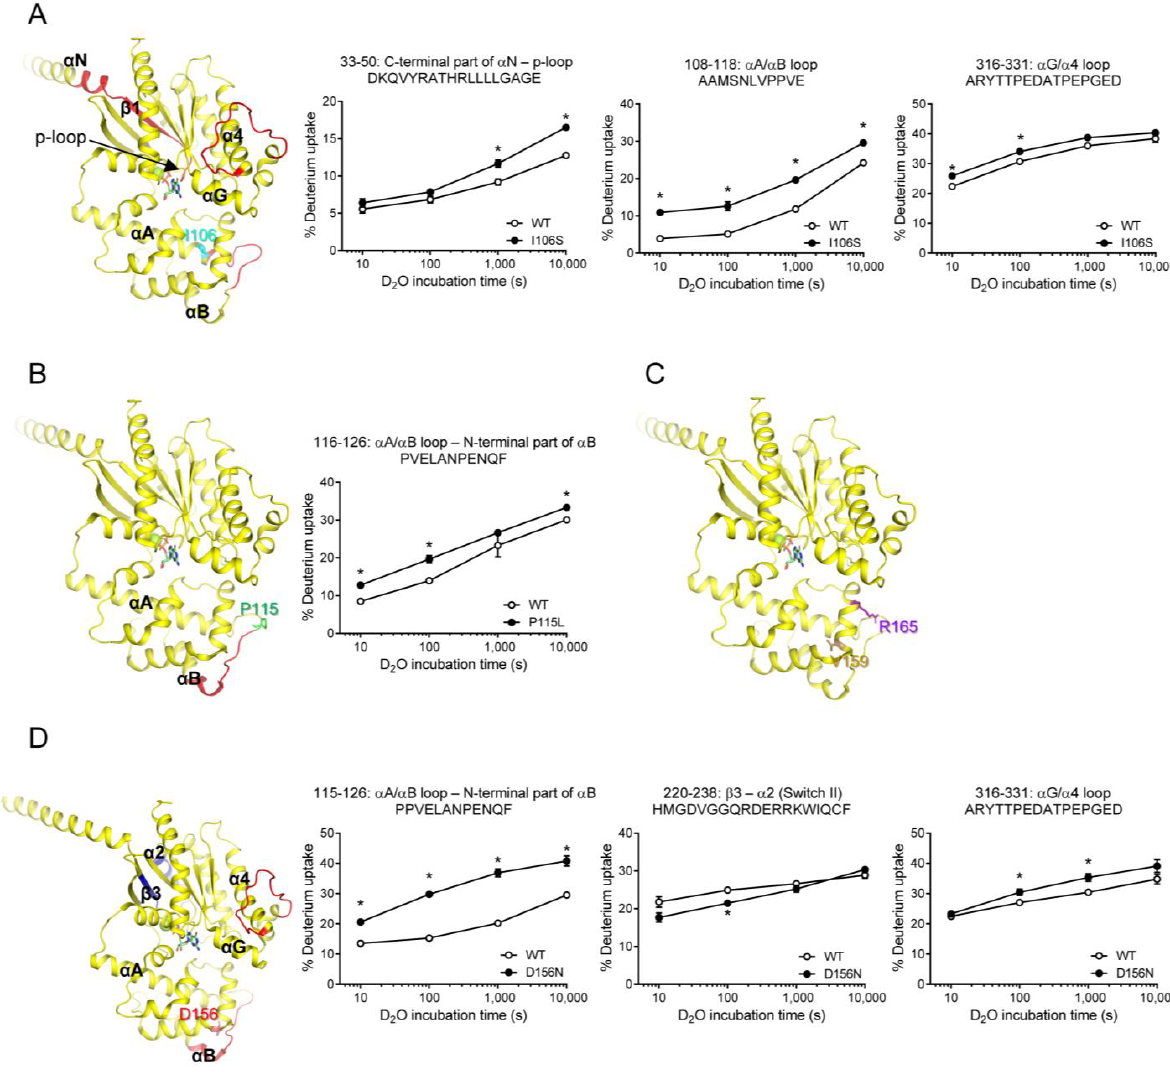
Figure 4. HDX-MS profiles of natural variants mutated within AHD. HDX-MS profiles of I106S ( A ), P115L ( B ), V159M and R165C ( C ), and D156N ( D ) are presented as color code on the structure of GDP-bound G α s (PDB: 6EG8), and uptake plots of selected peptides are shown. Red represents higher deuterium uptake of Gαs natural variants compared to the WT. Blue represents lower deu- terium uptake of Gαs natural variants compared to the WT. The mutated residues are shown as sticks. * indicates statistical differences between the natural variant and WT ( p < 0.05).